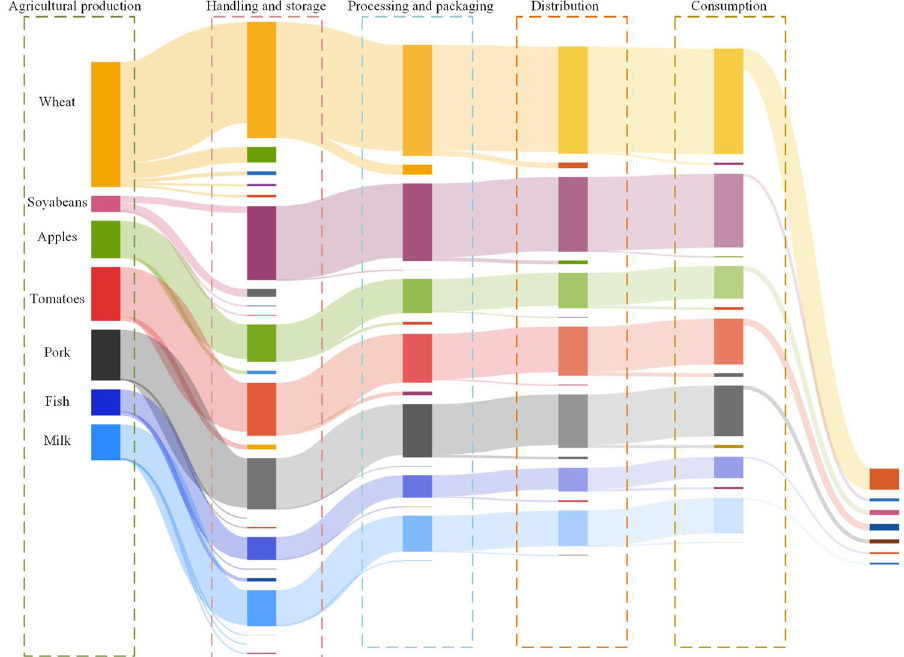
Fig. 1 China ’ s food supply chain Sankey map from 2010 to 2019. Food waste in China is quanti fi ed across fi ve stages of the food supply chain (labels on top), covering seven food categories (labels on left). Data are annual averages for the period 2010 –